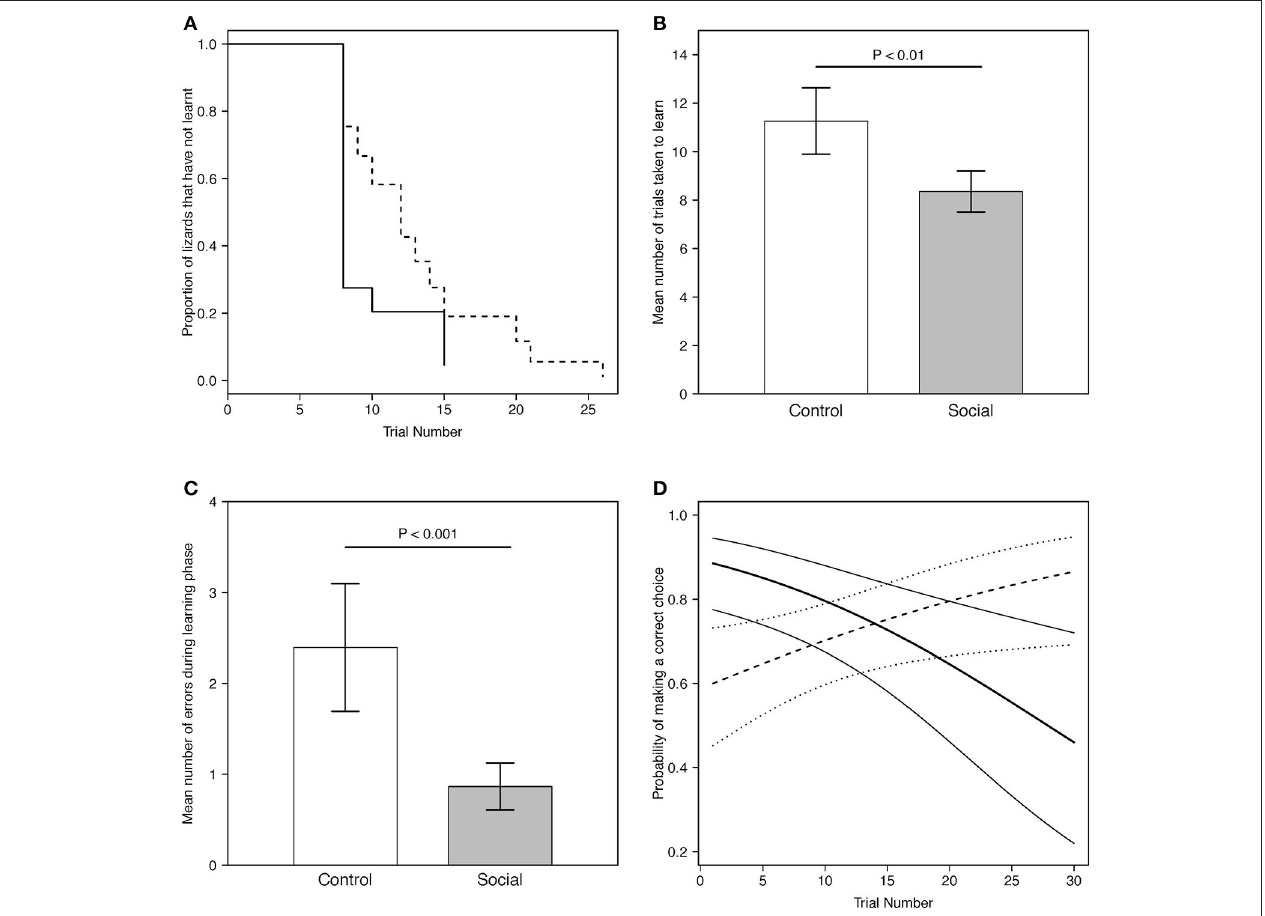
FIGURE 3 | (A) Predicted proportion of lizards across trials in the social learning treatment ( n = 15) and control group ( n = 13) that did not learn the association task. Predictions were averaged across both batches. The solid line represents the social learning treatment, the dashed line the control group. (B) Predicted mean number of trials taken to learn for lizards in the social learning treatment ( n = 15) and control group ( n = 13) in the association task ( Table 1B ). (C) Predicted mean number of errors made by lizards during the learning phase (i.e., prior to reaching the learning criterion) in the social learning treatment and control group in the association task ( Table 2 ). For visualization purposes, batch number was set to 1. Gray bars represent the social learning treatment; white bars represent the control group. Error bars represent the standard error. (D) Predicted probability of making a correct choice across trials for lizards in the social learning treatment ( n = 15) and control group ( n = 13) in the association task ( Table 3A ). For visualization purposes, batch number was set to 1. The thick solid line represents the social learning treatment and the thick dashed line the control group. Thin solid lines and the dotted lines represent the 95% credible interval for the social learning treatment and the control group, respectively.